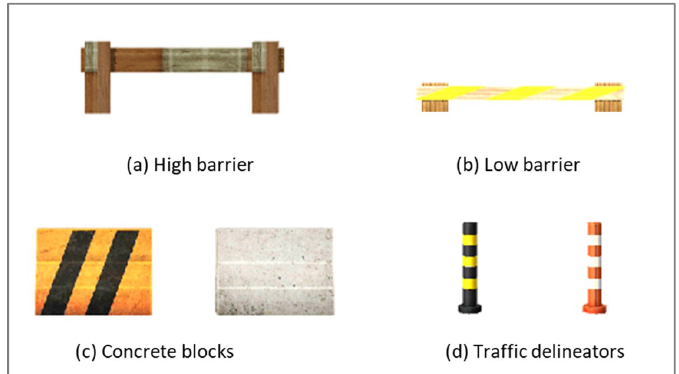
F igure 4. RabbitRun game obstacles.